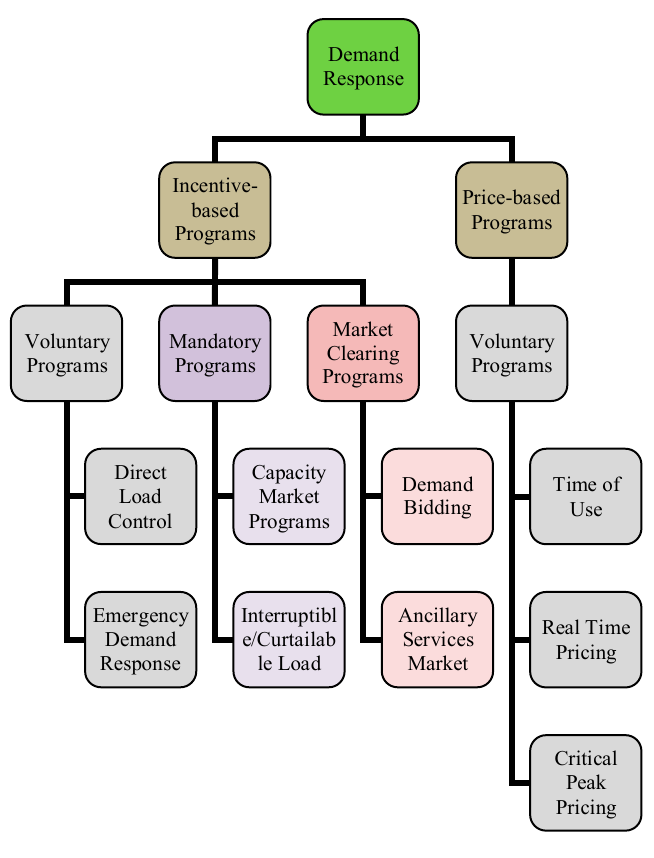
Figure 3. Classification of demand response programs [36].